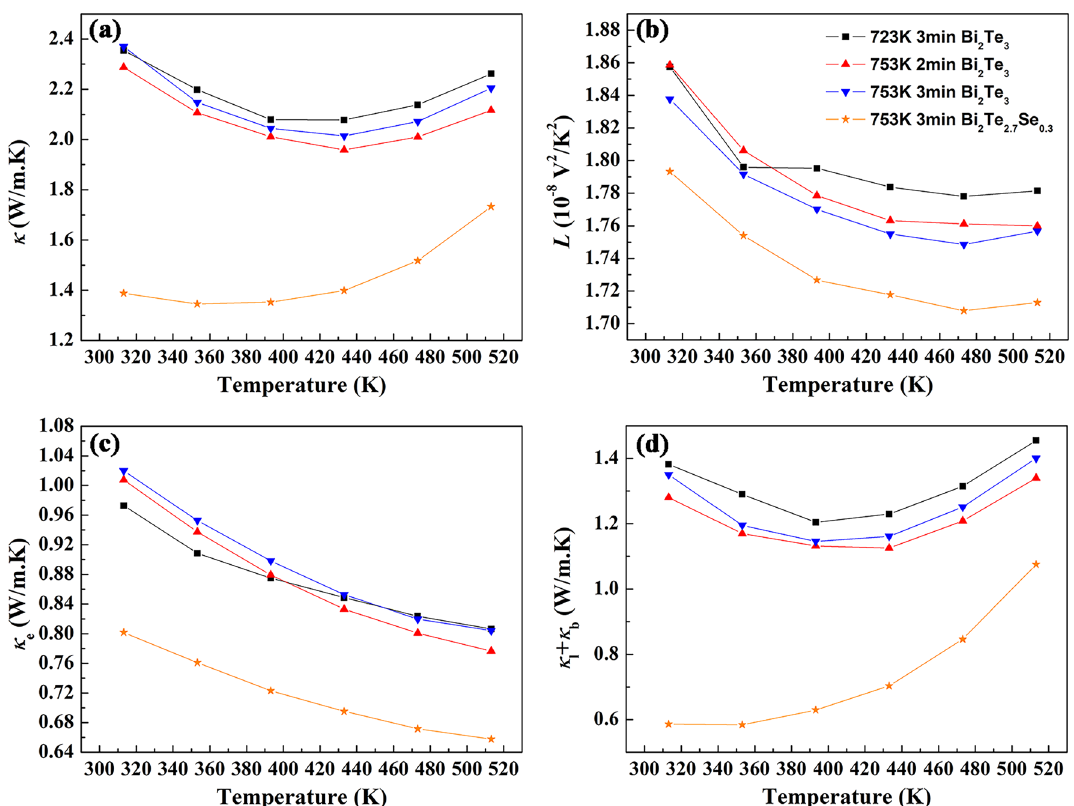
Figure 5. Thermal transport properties of the bulk Bi 2 Te 3−x Se x samples prepared by SPS on different conditions. Temperature dependence of ( a ) total thermal conductivity κ , ( b ) Lorentz number L , ( c ) electronic thermal conductivity κ e and ( d ) lattice thermal conductivity κ l plus bipolar thermal conductivity κ b .